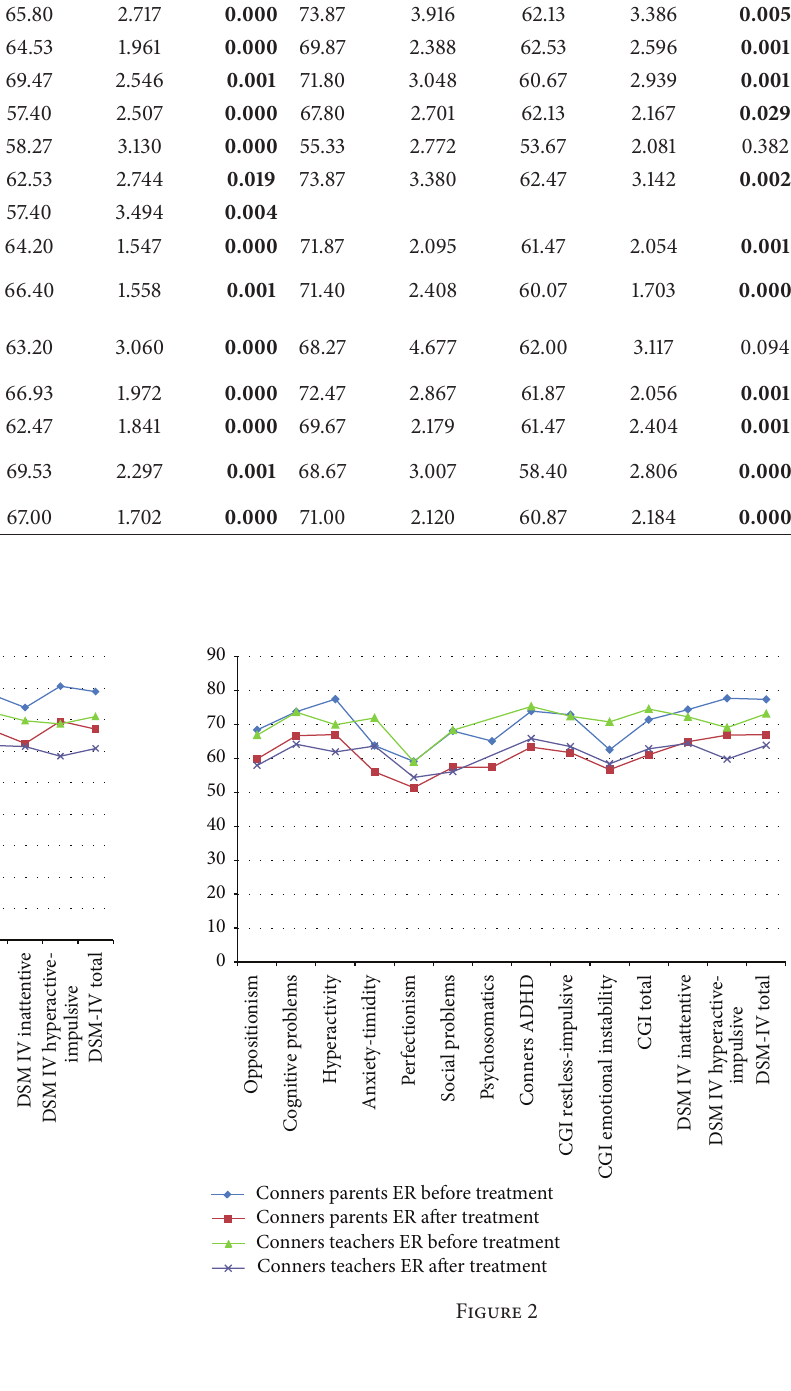
significant differences existed in either the first or the second